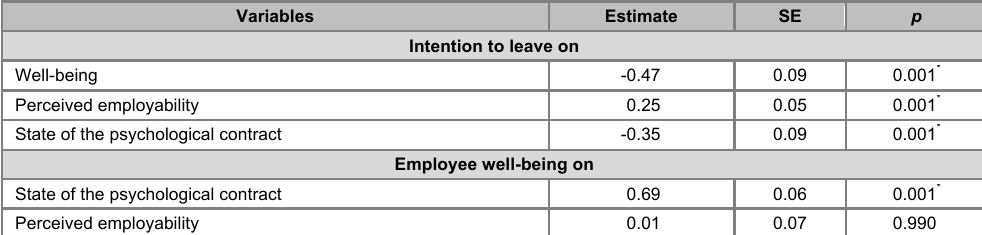
Standardised regression coefficients of the